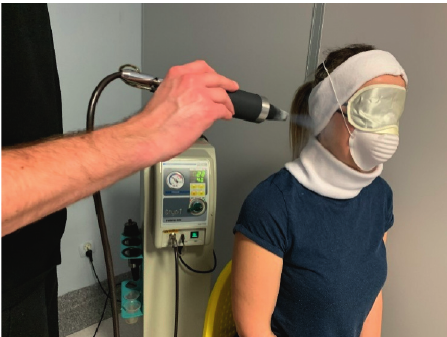
Figure 2: Local cryotherapy procedure in the TMJ area (author’s photo).